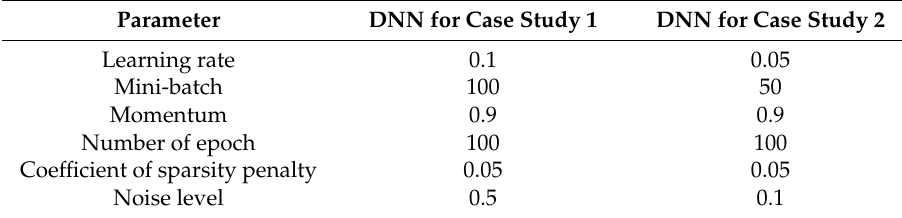
Table 2. Parameters of